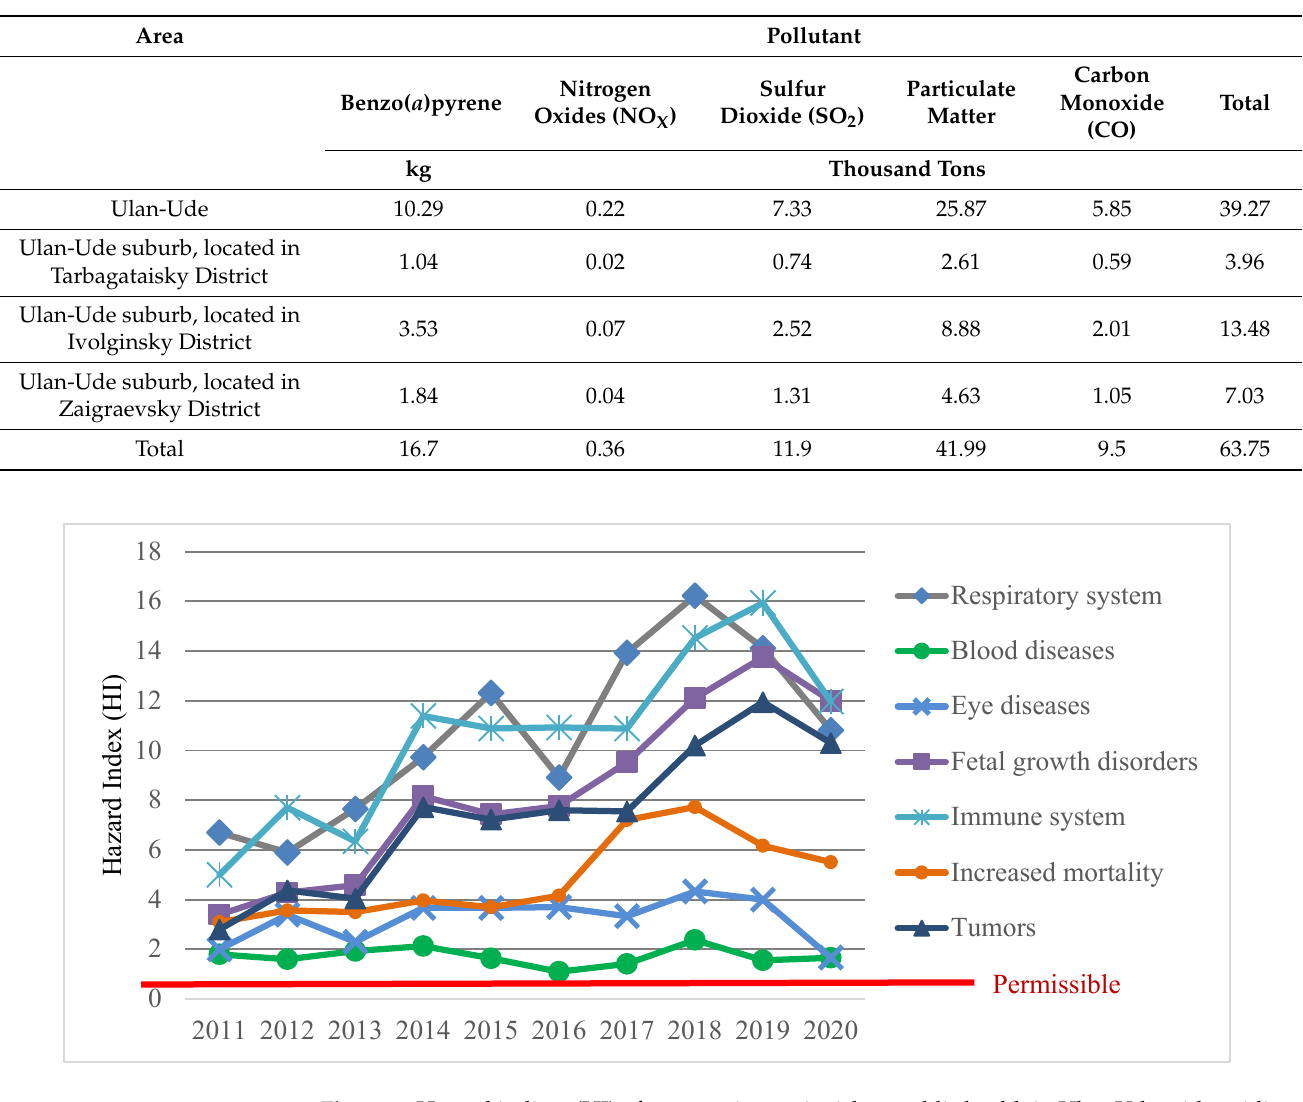
Table 4. Total pollutant emissions from households in Ulan-Ude and its suburbs per year (during the heating season 2020/2021.